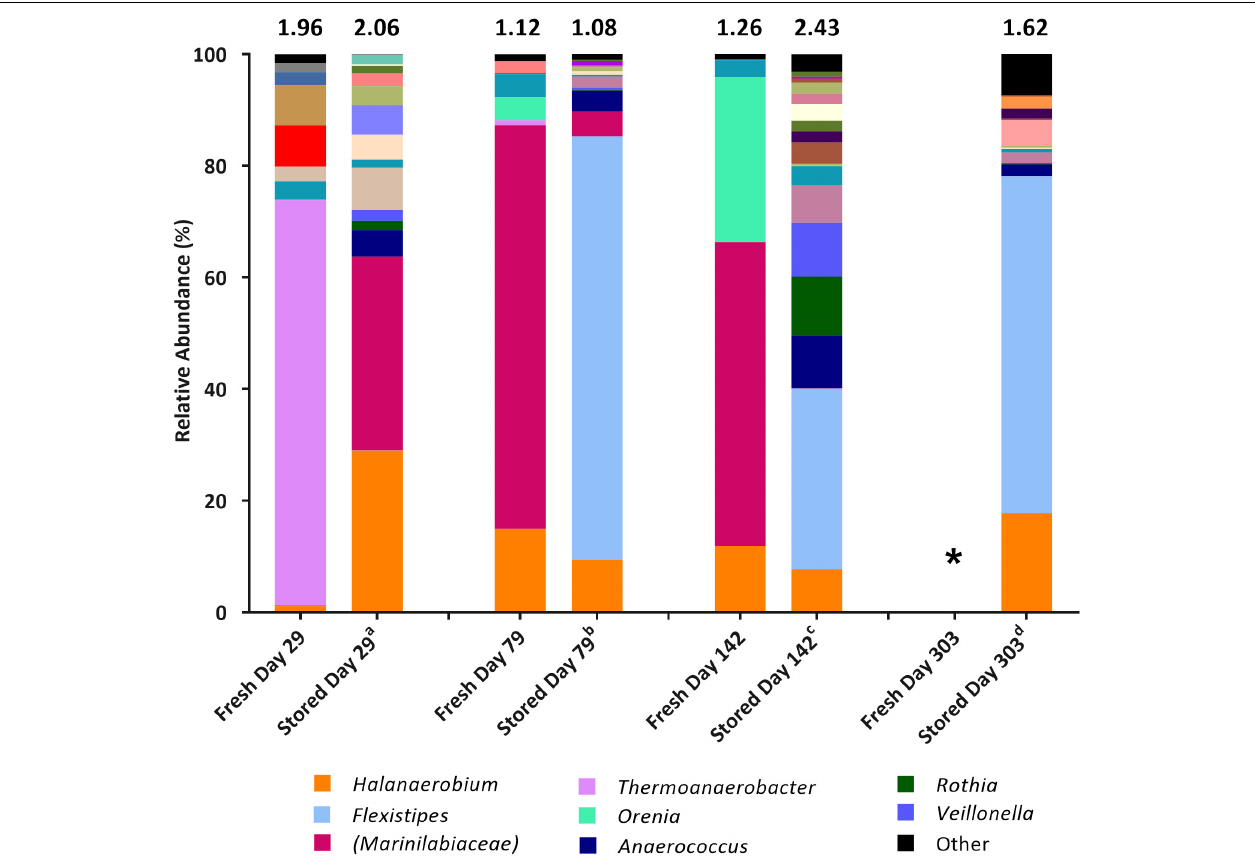
FIGURE 1 | Genus-level microbial community comparison based on 16S rRNA gene sequencing from fresh samples (DNA extracted shortly after collection) compared with stored samples (DNA extracted at the time of initial MPN inoculation). DNA was extracted from fresh samples shortly after sample collection, DNA was extracted from stored samples at the time of initial MPN inoculation. Where genus level could not be resolved the last matched taxonomic level was assigned in brackets. “Other” is comprised of taxa that represent less than 1% relative abundance combined across all samples. The Shannon diversity index calculated from operational taxonomic units is displayed above each bar. a 808 days storage, b 758 days storage, c 695 days in storage, and d 534 days in storage. * denotes 16S rRNA gene data unavailable. Key taxa are highlighted in